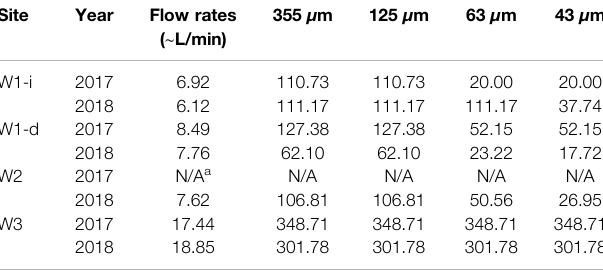
TABLE 1 | The sample volume of various mesh screens at different